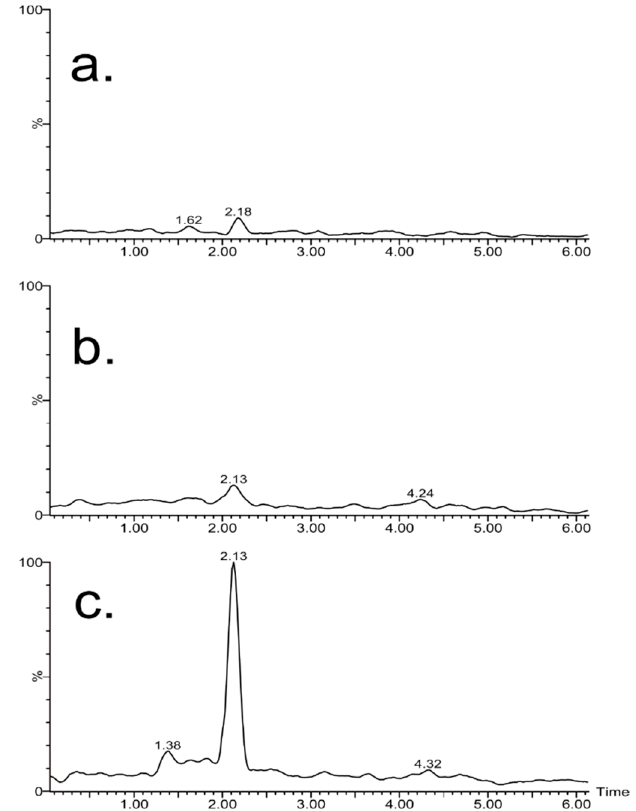
Figure 6. Ethylenethiourea (ETU) retention time chromatogram for each treatment sample and measured by ultra-high-performance liquid chromatography–mass spectrometry (UPLC-QTof-MS): ( a ) Thermal degradation, ( b ) UV photodegradation, and ( c ) electrochemical oxidation.